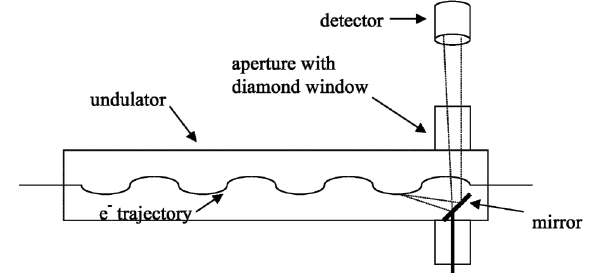
FIG. 11. Off-axis radiation